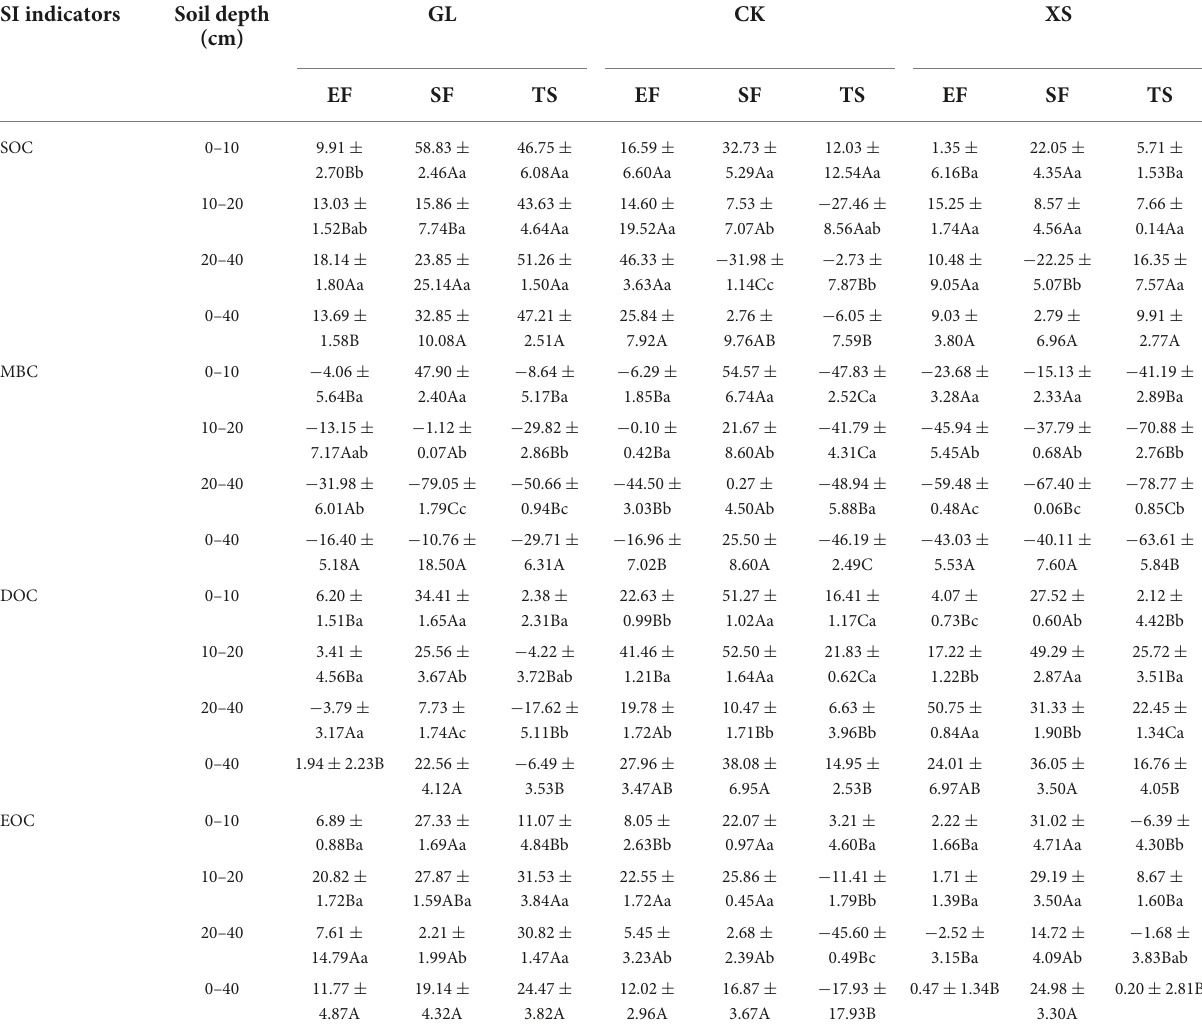
TABLE 5 Sensitivity index (SI) values of SOC, MBC, DOC, and EOC during seasonal FT under different vegetation restoration types. SI indicators Soil depth